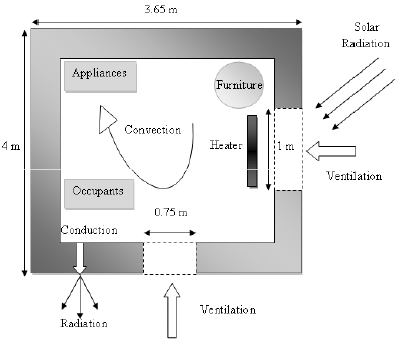
Figure 3: Dimensions and elements of the building